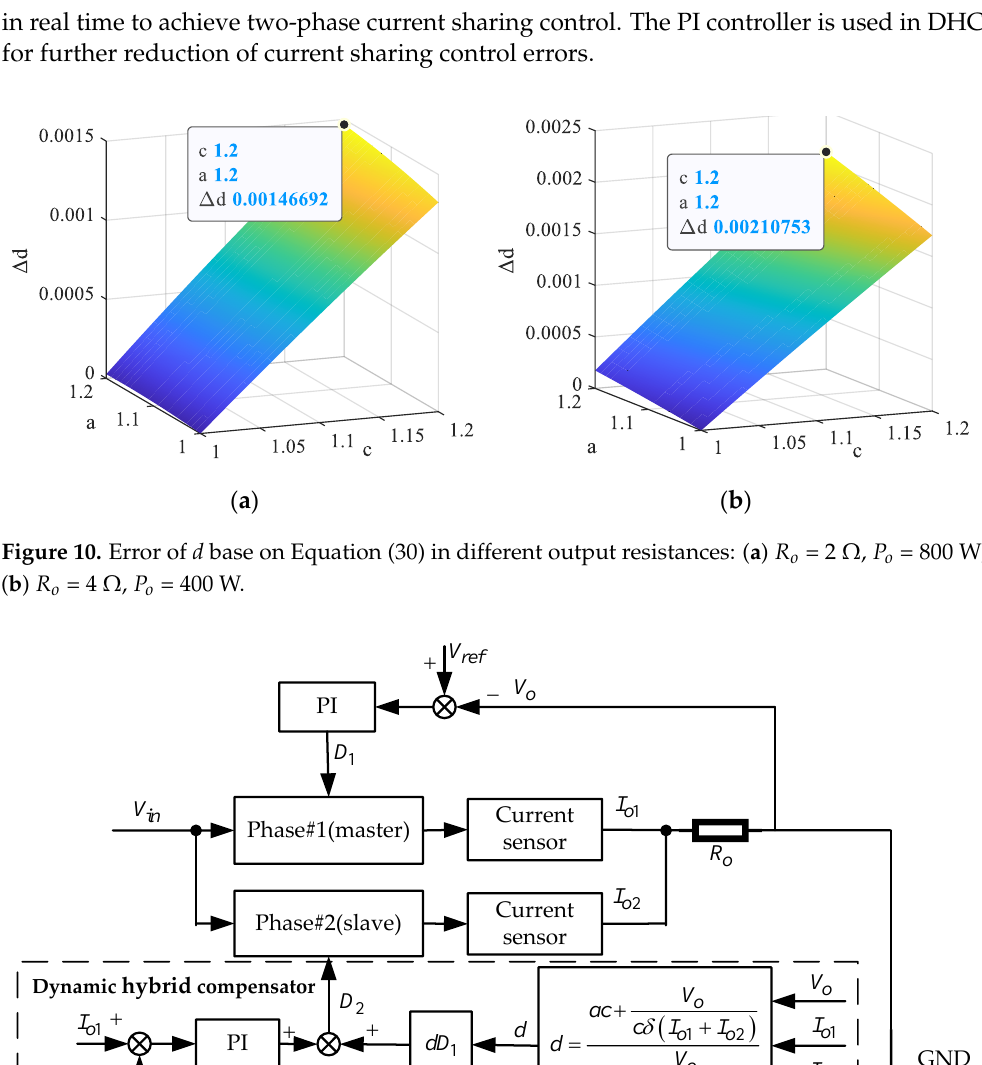
Figure 9. Solution of d after simplifying in different output resistances: ( a )